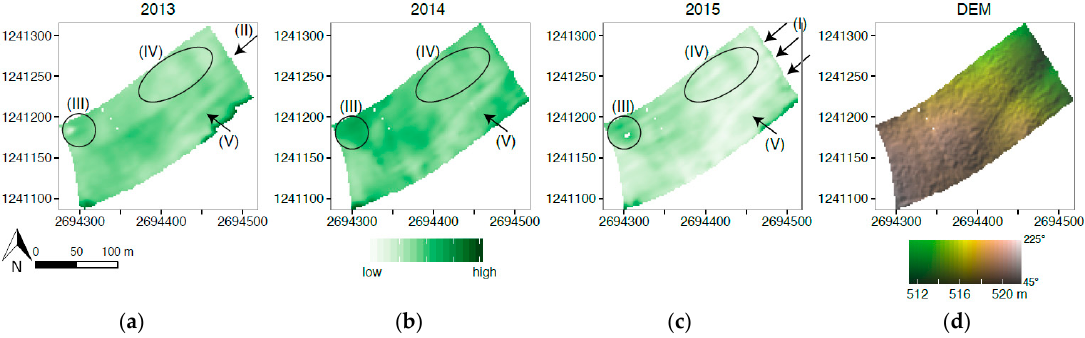
Figure 11. In-field variability shown by the first PC values: ( a – c ) for an individual agricultural field for all three years (2013, 2014, and 2015); and the corresponding DEM (overlaid with a hillshade: 315° azimuth and 45° altitude) ( d ).